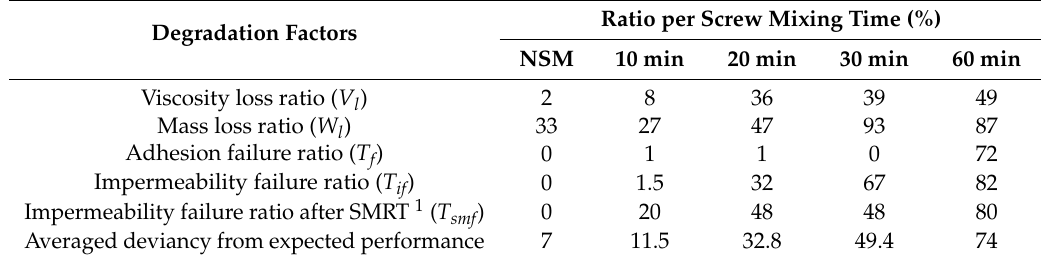
Table 9. Estimation of the deviancy from the expected performance of SPRG (2 days storage).